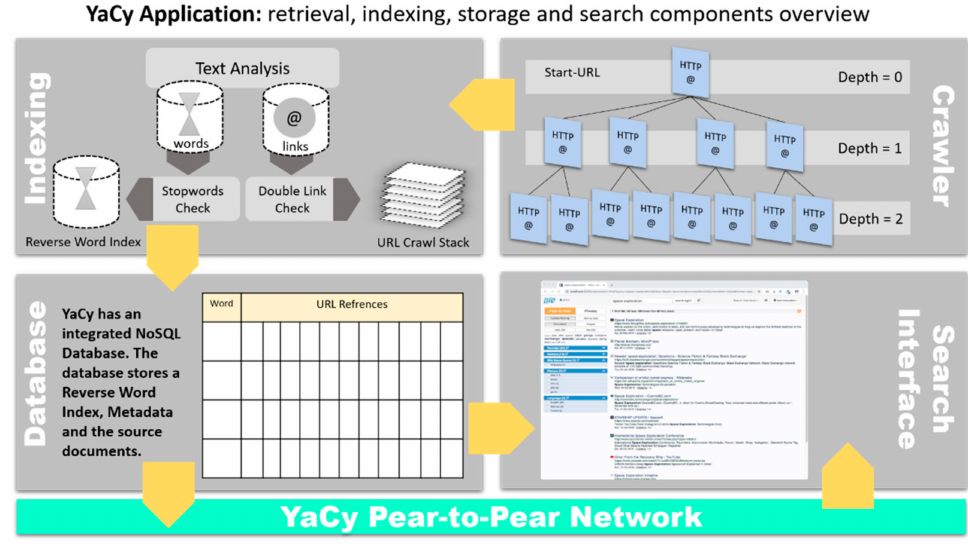
Figure 3. The YaCy architecture